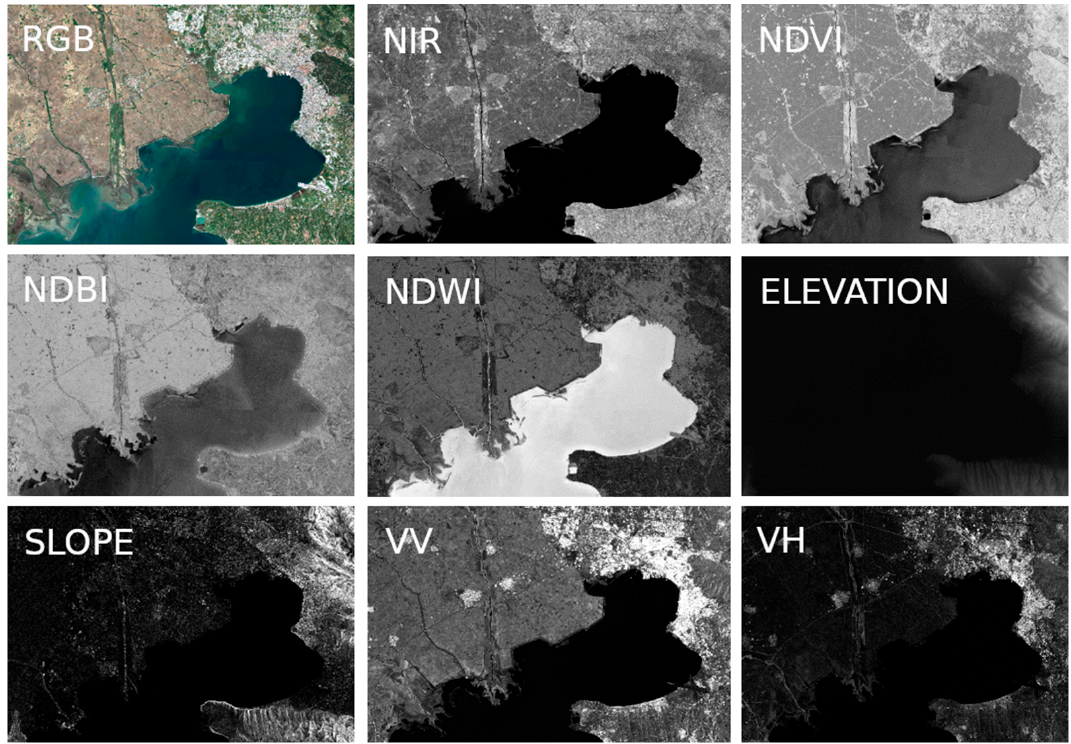
Figure 3. Visualisation of di ff erent bands from the input dataset.